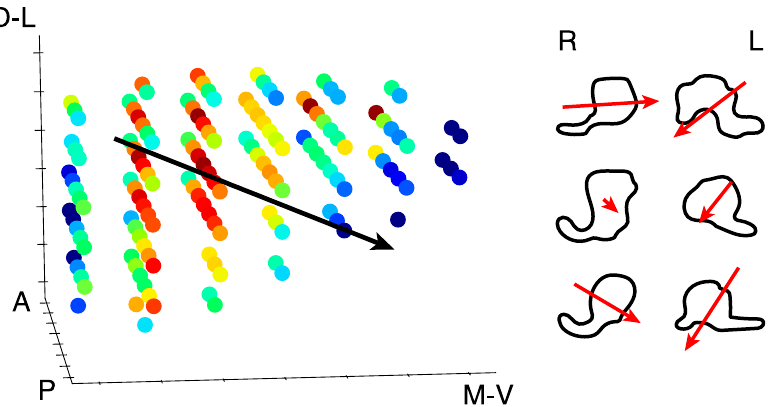
Figure 5. Weight parameter gradient. Left panel: All of the voxels in one LGN are shown to highlight the gradient of the transient-sustained weight parameter. Red voxels exhibit sustained responses whereas blue voxels exhibit a transient response. The black line indicates the direction of the gradient from sustained to transient through the whole LGN, from dorsolateral (D-L) to ventromedial (V-M). Anterior (A) and posterior (P) directions are also labeled. Right panel: The right (R) and left (L) LGN from each of the three subjects are shown outlined in the coronal plane. The red arrows indicate the direction and magnitude of the gradient from sustained to transient. Vision 2019 , 3 , x